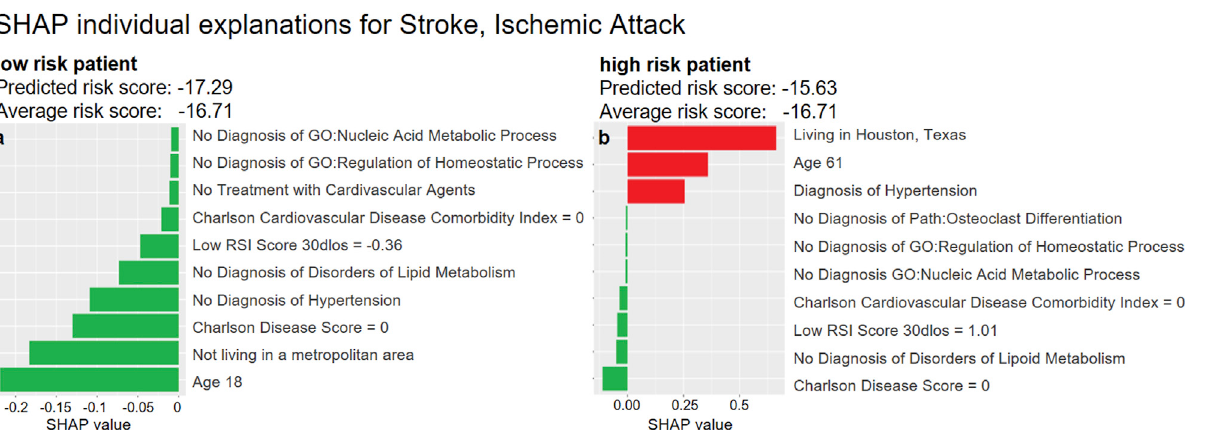
FIGURE 10 | Examples of SHAP explanations for a patient predicted at low risk for stroke and ischemic attacks (left) and a high-risk patient (right) . Red (green) bars indicate higher (lower) risk than the average patient: The hazard ratio 2 of the low-risk patient (left) is around 56% of that of an average patient ( exp (− 17 . 29 ) / exp (− 16 . 71 ) (cid:1) 0 . 56 ) .Thehazardratioofthehigh-riskpatient (right) isaround2.94timesthatofanaveragepatient ( exp (− 15 . 63 ) / exp (− 16 . 71 ) (cid:1) 2 . 94 )